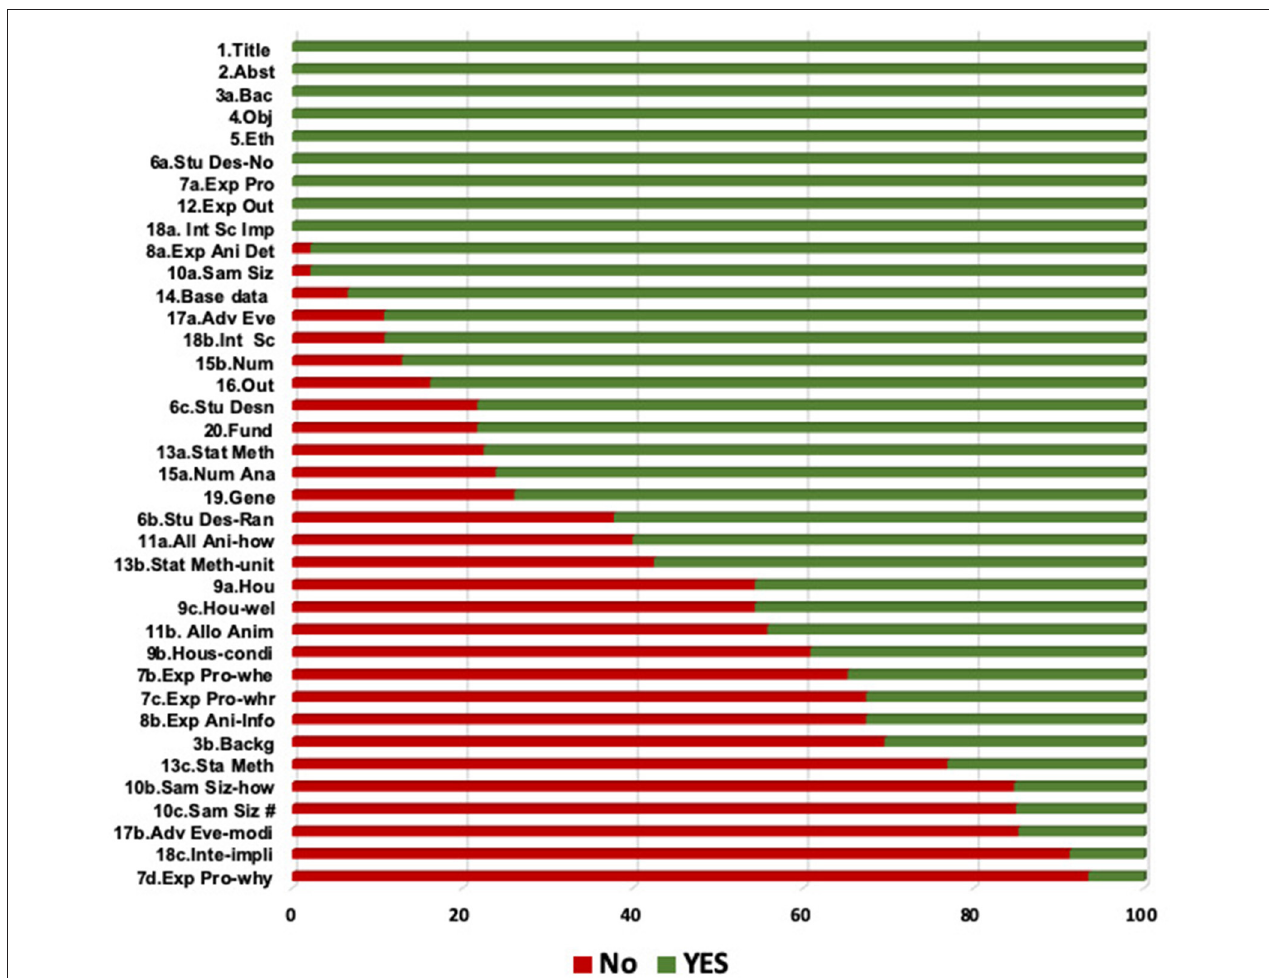
FIGURE 2 | Bar chart displaying the frequencies of the options “Yes” and “No” among the 22 articles selected for the analysis. Items are indicated by their corresponding numbers and a label associated with their content. Alloc Ani , allocation of animals; Exp ani , experimental animals; Basel , baseline data; Fund , funding; Generali , generalizability; Stu desig , study design; Sample , sample